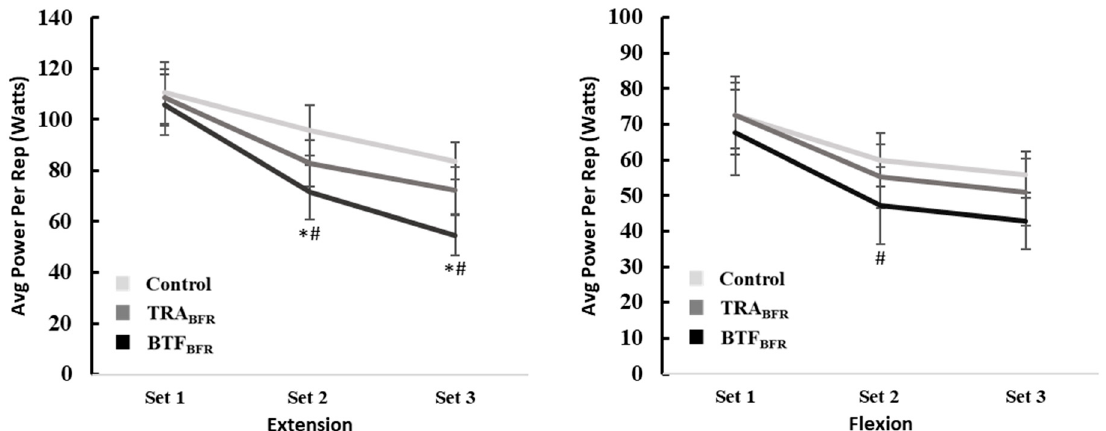
Figure 4. Average power per rep during extension and flexion (M ± SEM). # = Significantly different from CON; * = Significant difference within condition. CON = control; TRA BFR = blood flow restriction; BTF BFR = band tissue flossing. Statistical significance is noted at an alpha level of p < 0.05.